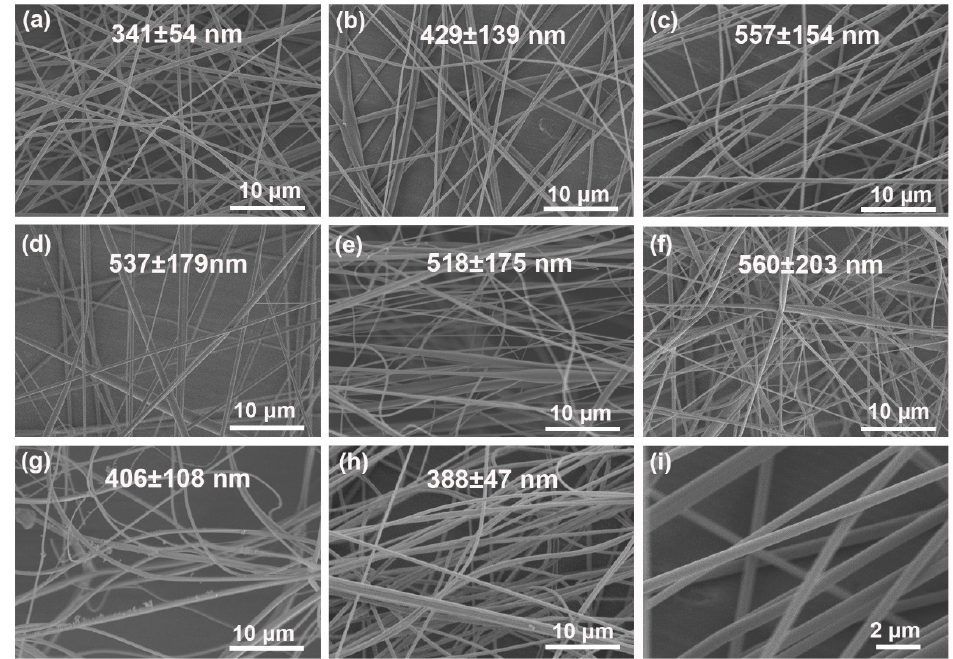
Figure 2. SEM and diameter of PAA nanofiber under different electrospinning parameters. The feeding rate, voltage, and collecting distance was ( a ) 0.5 mL/h, 15 kV, 18 cm; ( b ) 0.8 mL/h, 15 kV, 18 cm; ( c ) 1.2 mL/h, 15 kV, 18 cm; ( d ) 0.5 mL/h, 10kV, 18 cm; ( e ) 0.5 mL/h, 20 kV, 18cm; ( f ) 0.5 mL/h, 15 kV, 10cm; ( g ) 0.5 mL/h, 15 kV, 26cm; ( h , i ) 0.5 mL/h, 15 kV, 18 cm, after sintering, respectively.